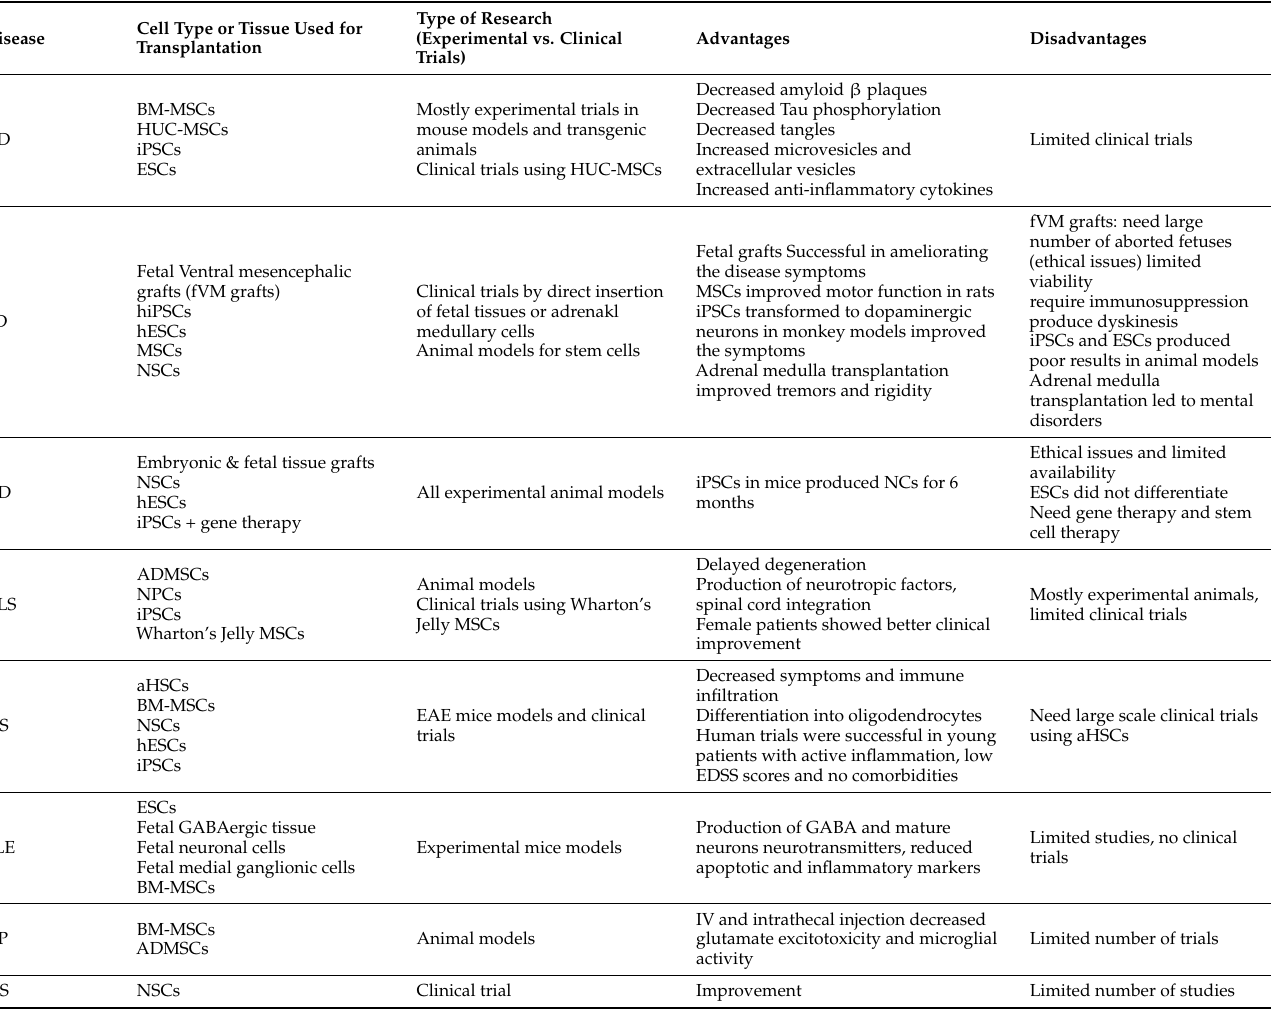
Table 1. Summary of the reviewed neurological diseases and the types of cells used in experimental studies and/or clinical trials.